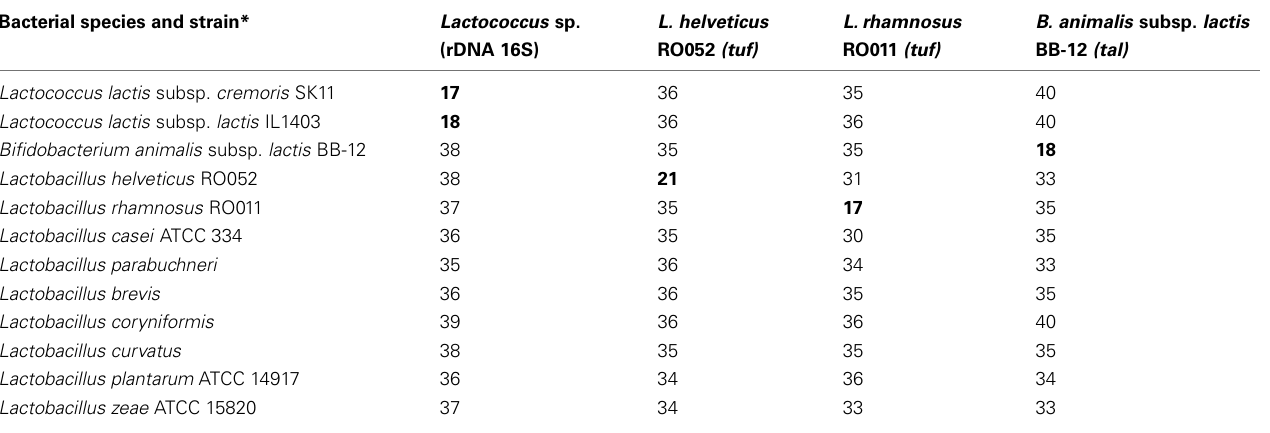
Table 3 | Specificity of primers and probe ( C t results) for gene quantification. Bacterial species and